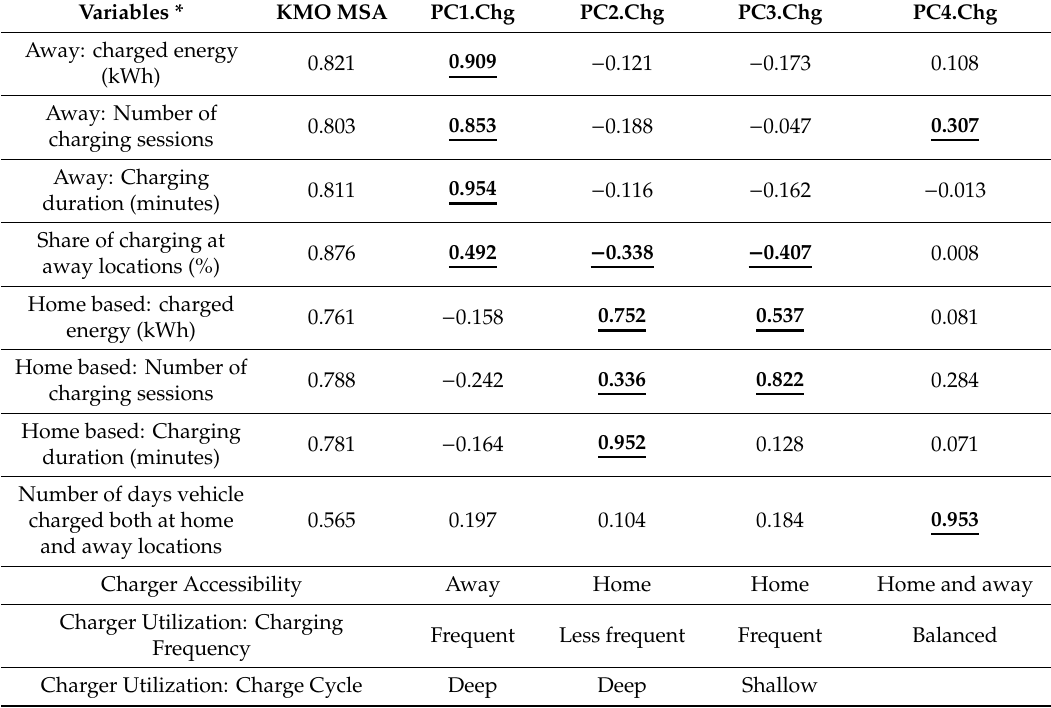
Table 8. PCA of Charging Behavior: Varimax Rotated Factor Loadings and Influential Charging Traits